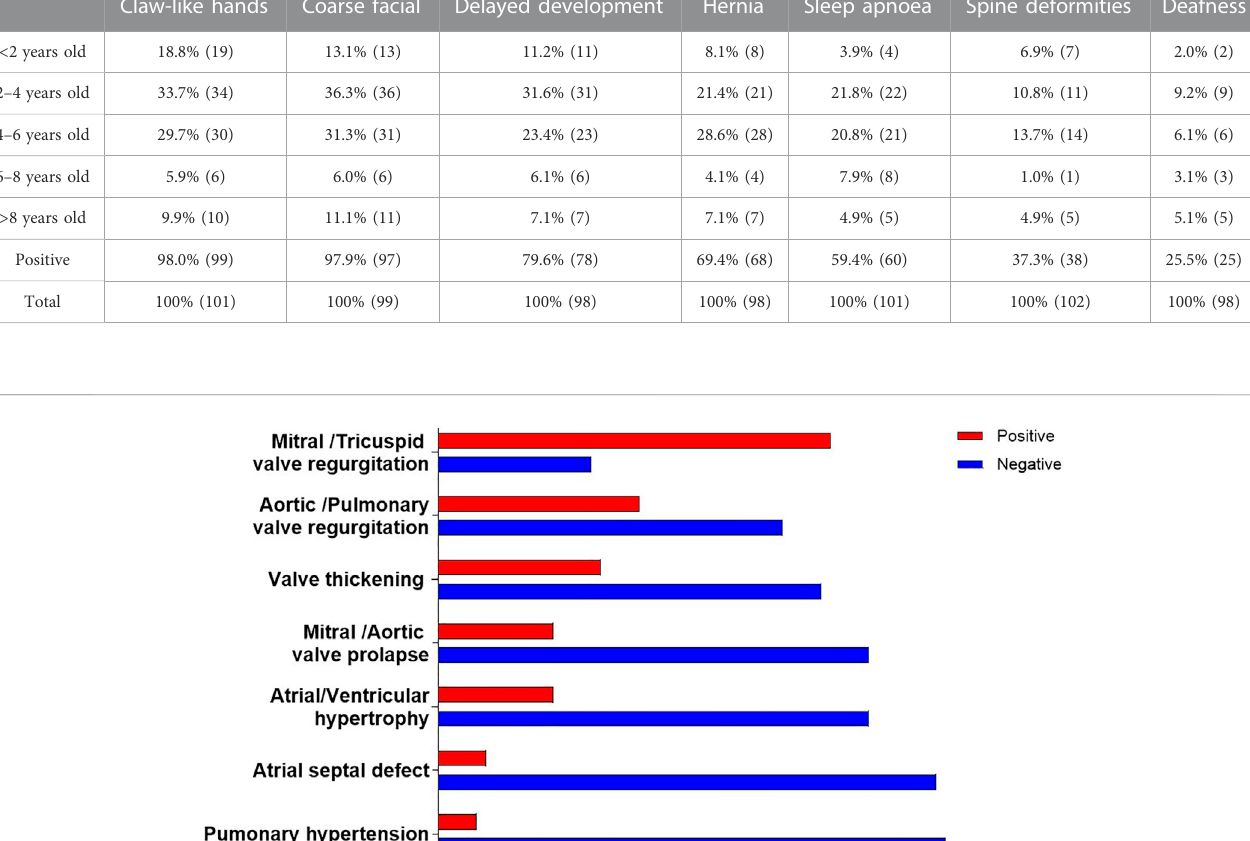
TABLE 1 Patient age at onset of clinical manifestations of MPS II. Percentage (Number). Claw-like hands Coarse facial